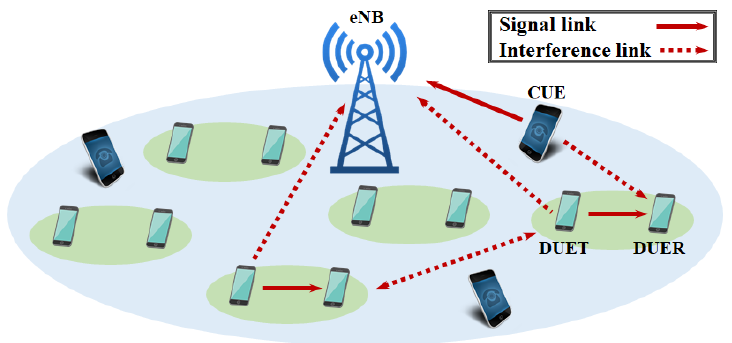
Figure 1. System model of D2D communications underlay cellular